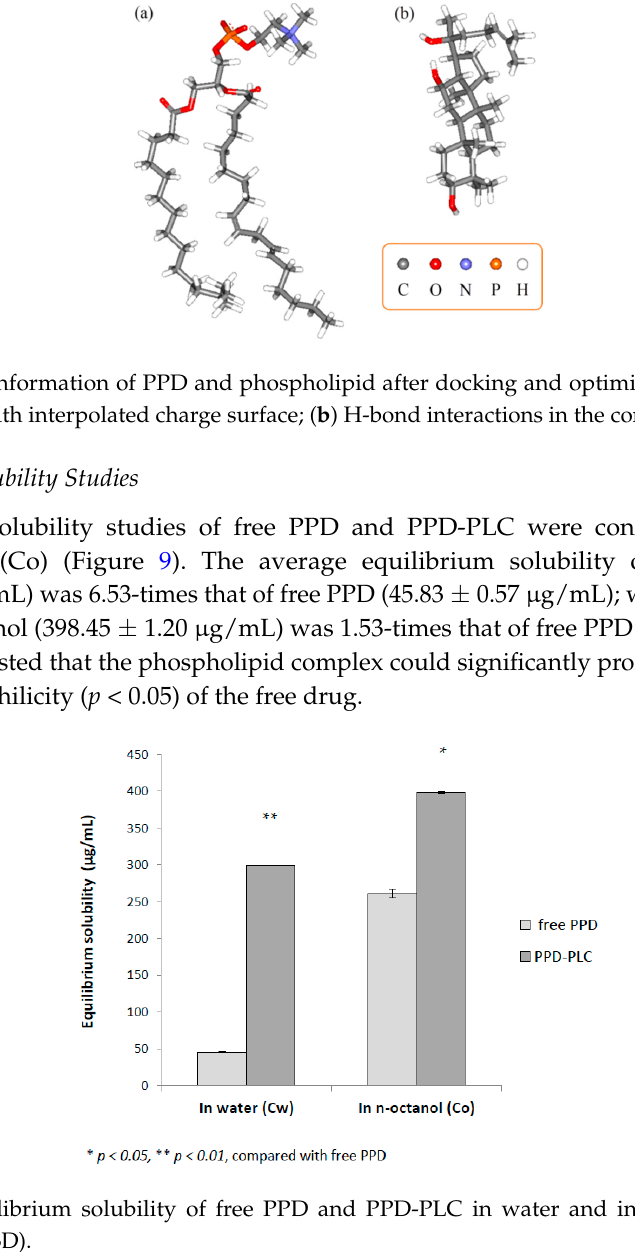
Figure 9. Equilibrium solubility of free PPD and PPD-PLC in water and in n -octanol at 25 °C ( n = 3, mean ± SD).